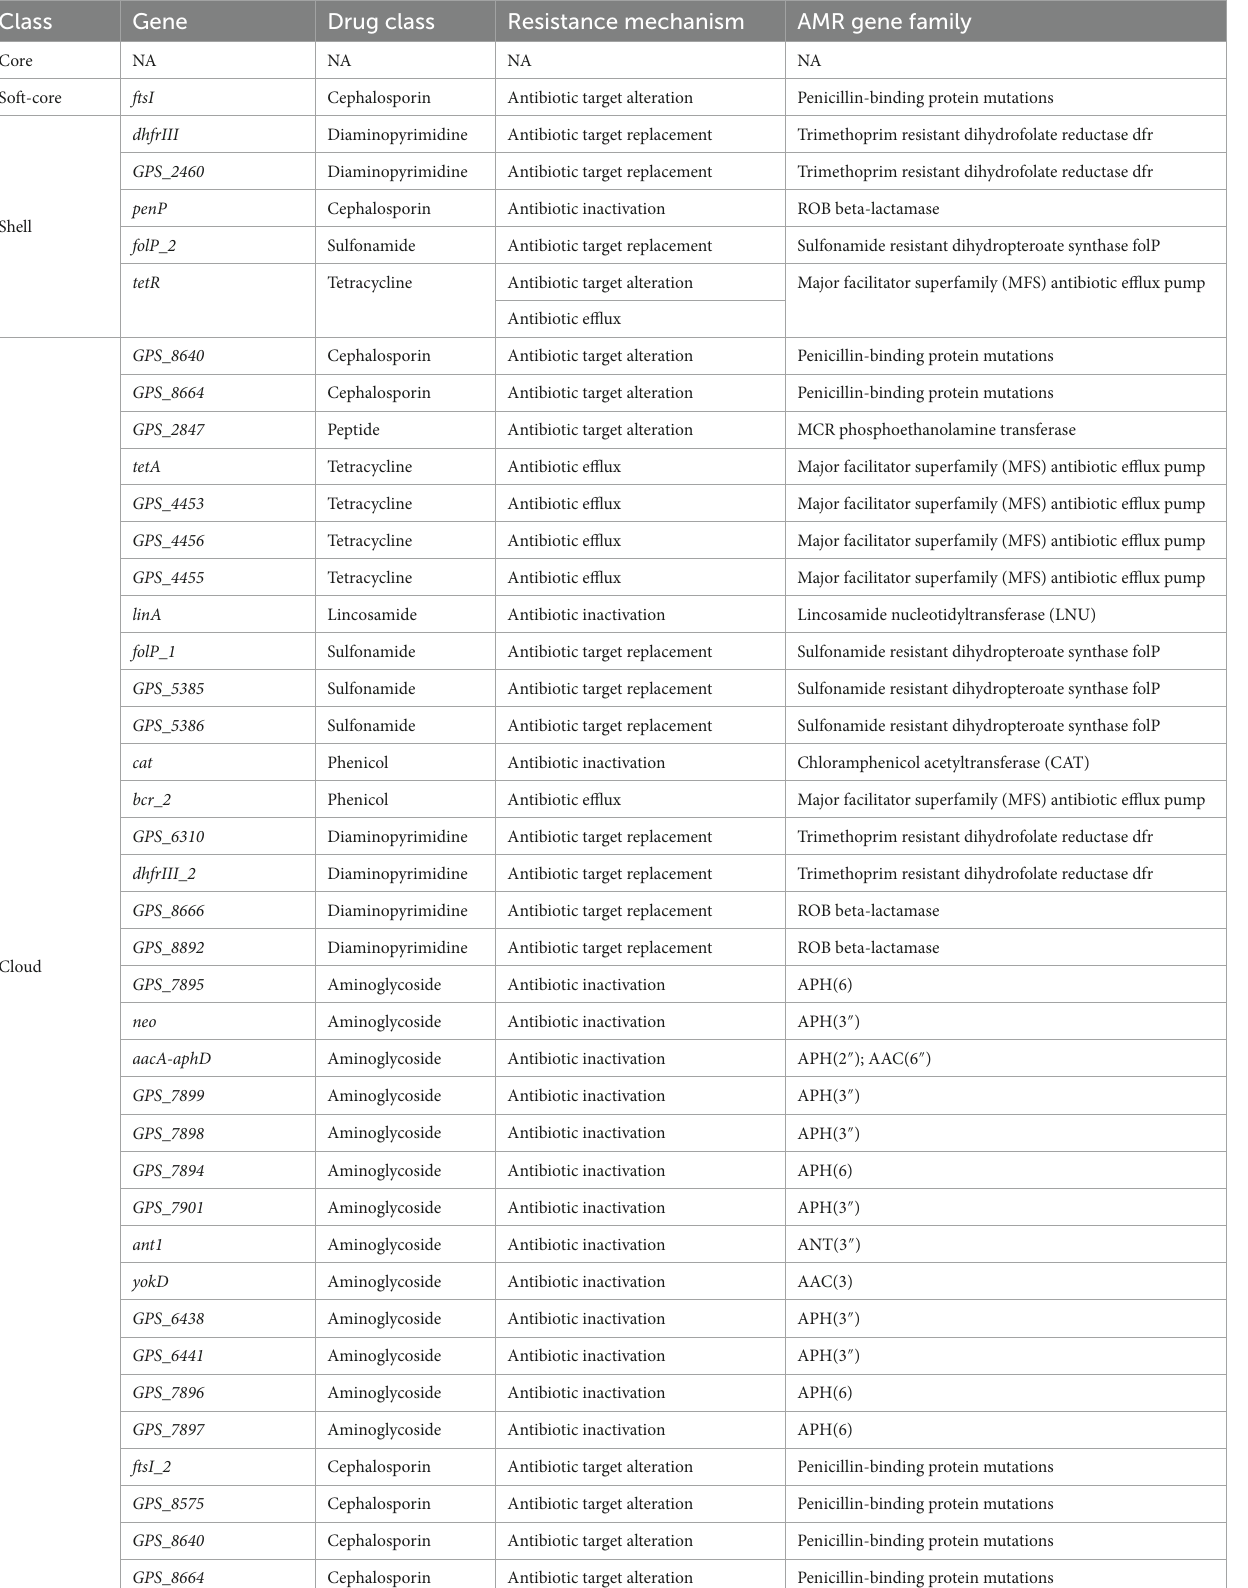
TABLE 7 CARD annotation of the core genome and the accessory genome (Perfect or Strict